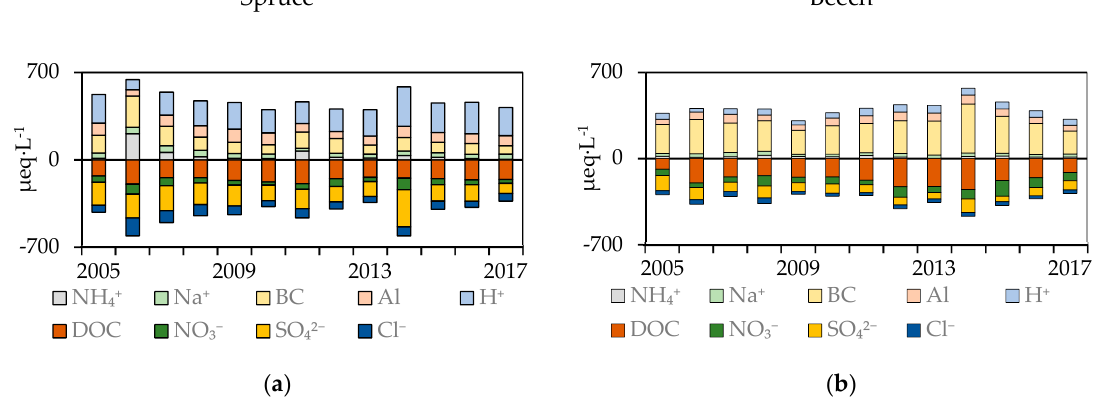
( b ) Figure 5. Soil solution concentrations from the depth of 90 cm in the spruce ( a ) and the beech ( b ) stand. DOC, NO 3 − , SO 42 − , and Cl − concentrations were reversed to show how reductions in acid anions were compensated by reductions of base cations, Al and H + . 3.2.3. NH 4+ , Na + , K + , Mg 2+ , Ca 2+ , and the Bc/Al in Ratio In both stands, NH 4+ concentrations decrease very rapidly with depth. A sharp decrease was measured between the forest floor and the mineral soil. In forest floor leachates, the NH 4+ concentrations were stable at around 39 ± 52 µeq·L − 1 and 17 ± 17 µeq·L − 1 under spruce and beech, respectively (Figure 4). Analysis of variance proved significantly higher NH 4+ concentrations in mineral soil solutions under beech when compared to under spruce at the depths of 30 cm (1.8 vs 1.4 µeq·L − 1 ) and 60 cm (2.5 vs 1.4 µeql·L − 1 ). However, annual concentrations at 90 cm were significantly greater in the spruce stand (1.2 vs 0.94 µeq·L − 1 ) (Figure 5). In the soil solution, the Na + concentrations increased with depth. The lowest Na + concentrations were recorded on the forest floor; in the spruce stand, the concentrations varied around 39 ± 9 µeq·L − 1 , whereas in the beech stand were around 25 ± 13 µeq·L − 1 (Figure 4). In the mineral soil under spruce, the